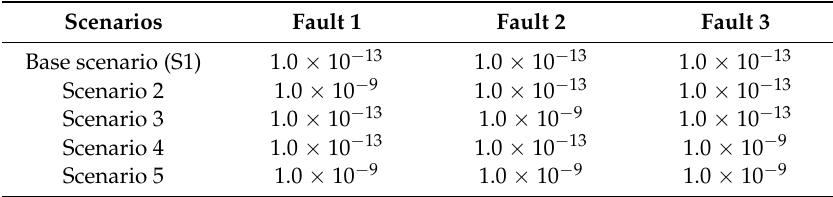
Table 4. Permeability distribution under four scenarios (m 2